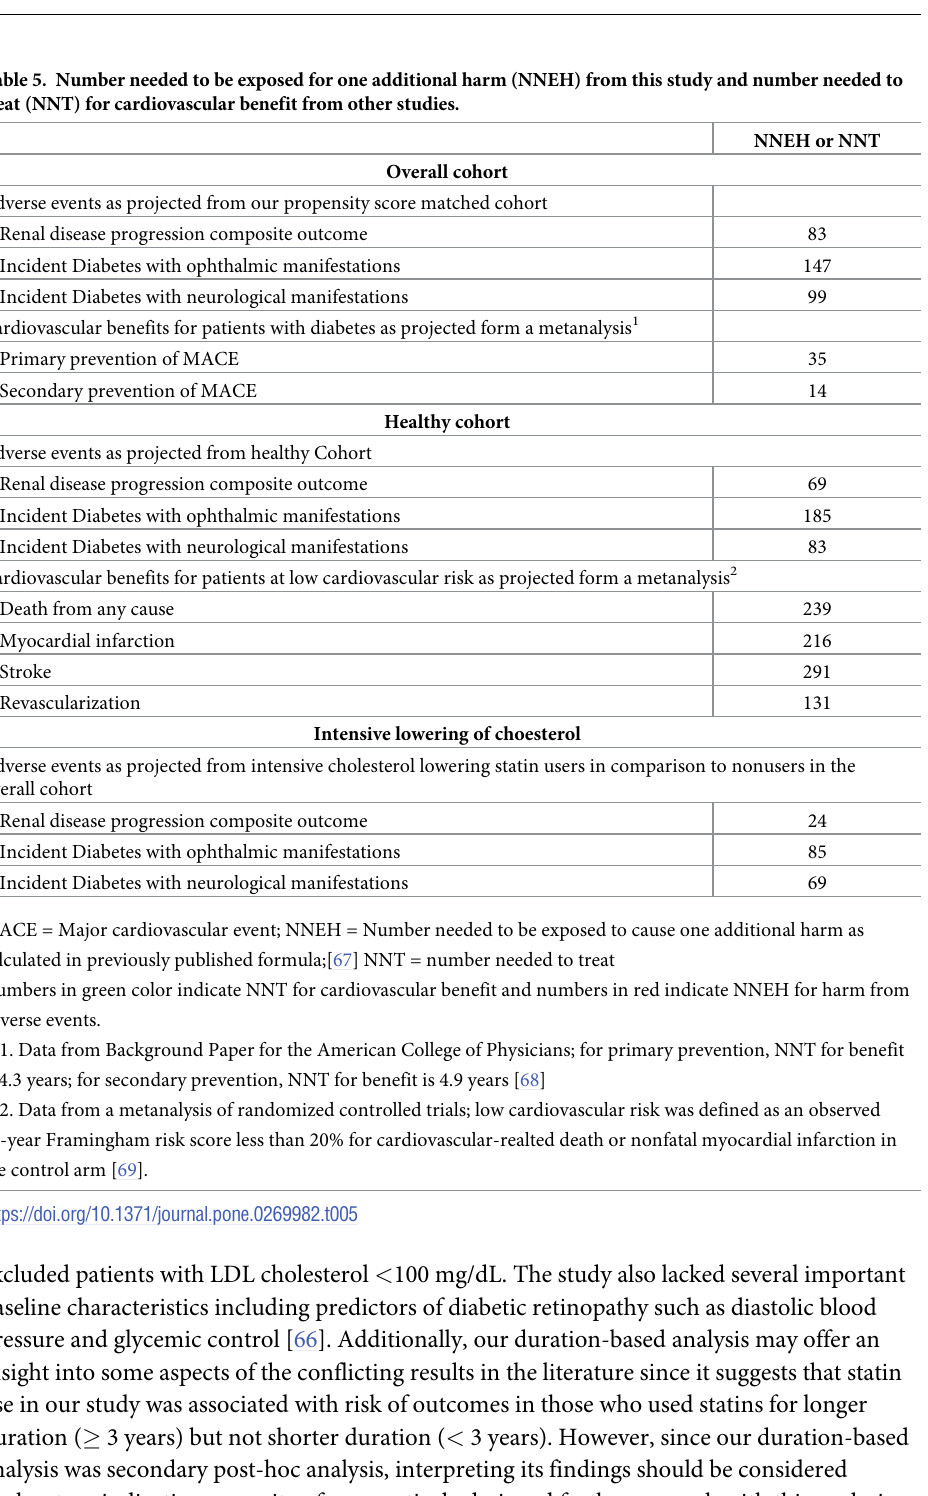
Table 5. Number needed to be exposed for one additional harm (NNEH) from this study and number needed to treat (NNT) for cardiovascular benefit from other studies.